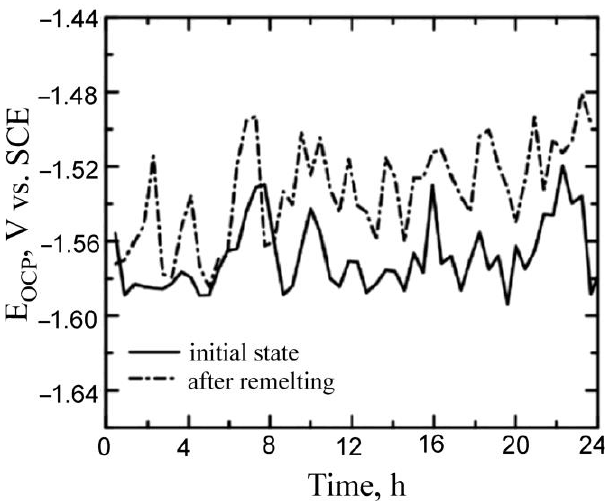
Figure 8. Open circuit potential recorded for remelted and non-remelted AZ91 magnesium alloy.